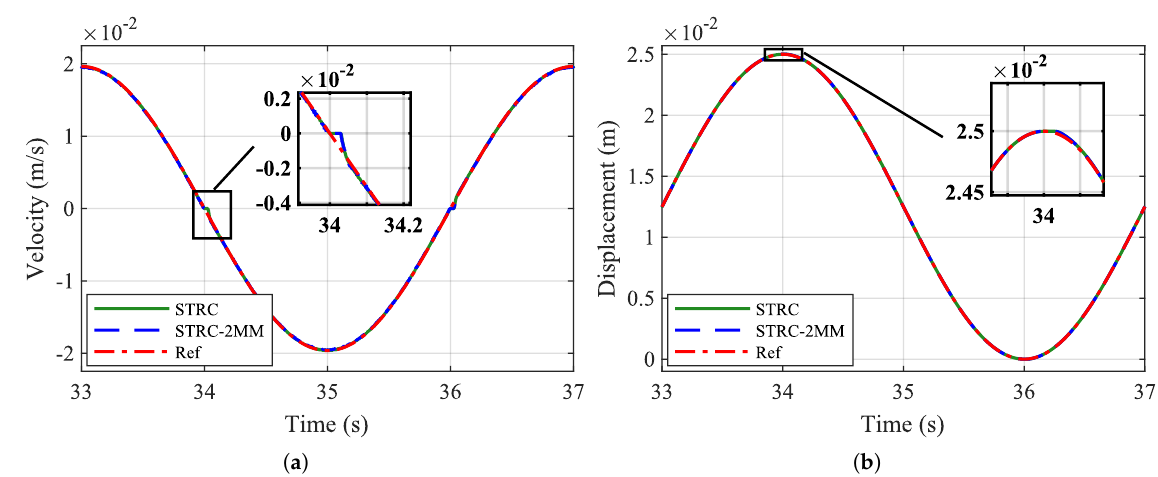
Figure 21. Simulation waveform comparison at 0.25 Hz. ( a ) Velocity; ( b )